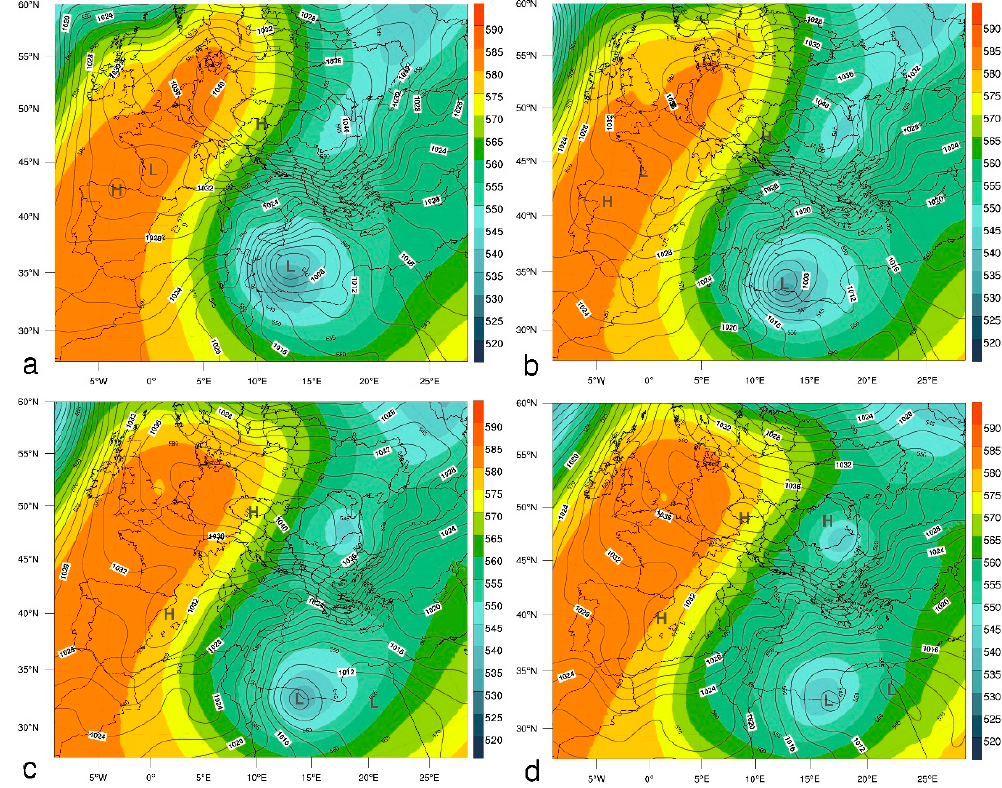
Figure A4. NCEP FNL analysis of 500-hPa geopotential height (shading at 50-gpdm intervals), sea-level pressure (thin black contours at 2-hPa intervals), valid on 24 February 2019 at ( a ) 0000 UTC, ( b ) at 0600 UTC, ( c ) at 1200 UTC, and ( d ) at 1800 UTC.